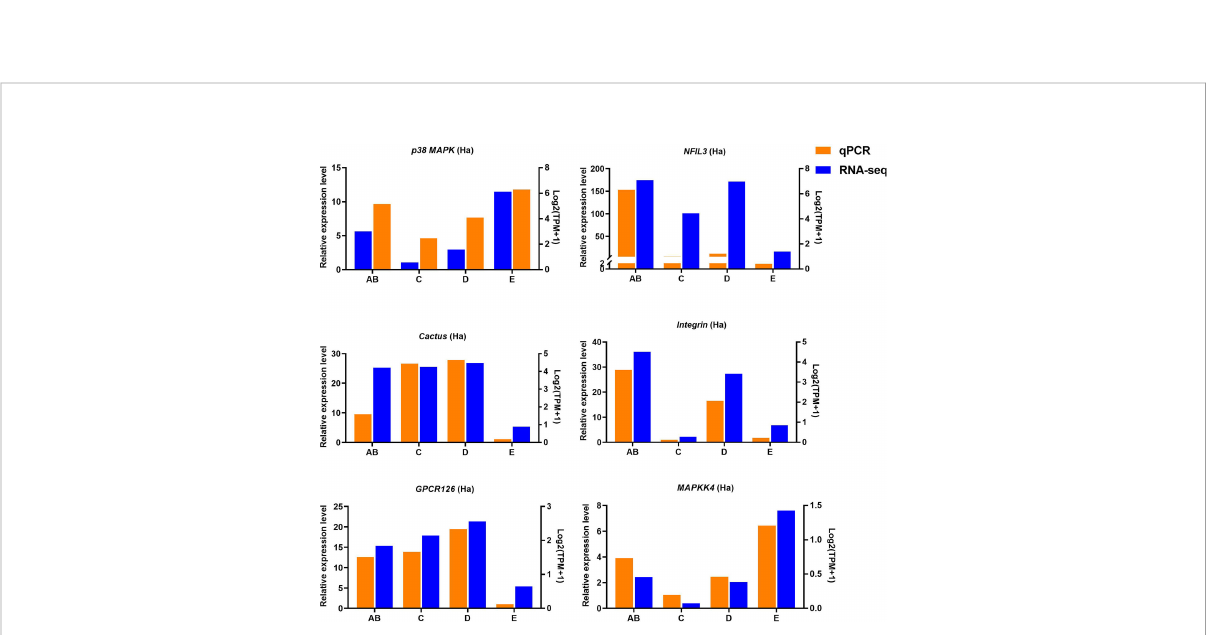
FIGURE 9 Quantitative expression of six genes was determined by qPCR in hemolymph from different molting stage of P. trituberculatus . p38 MAPK: p38 mitogen-activated protein kinase ; NFIL3: nuclear factor interleukin 3 – regulated transcription factor ; GPCR126: G-protein coupled receptor 126 ; MAPKK4 : mitogen-activated protein kinase kinase 4